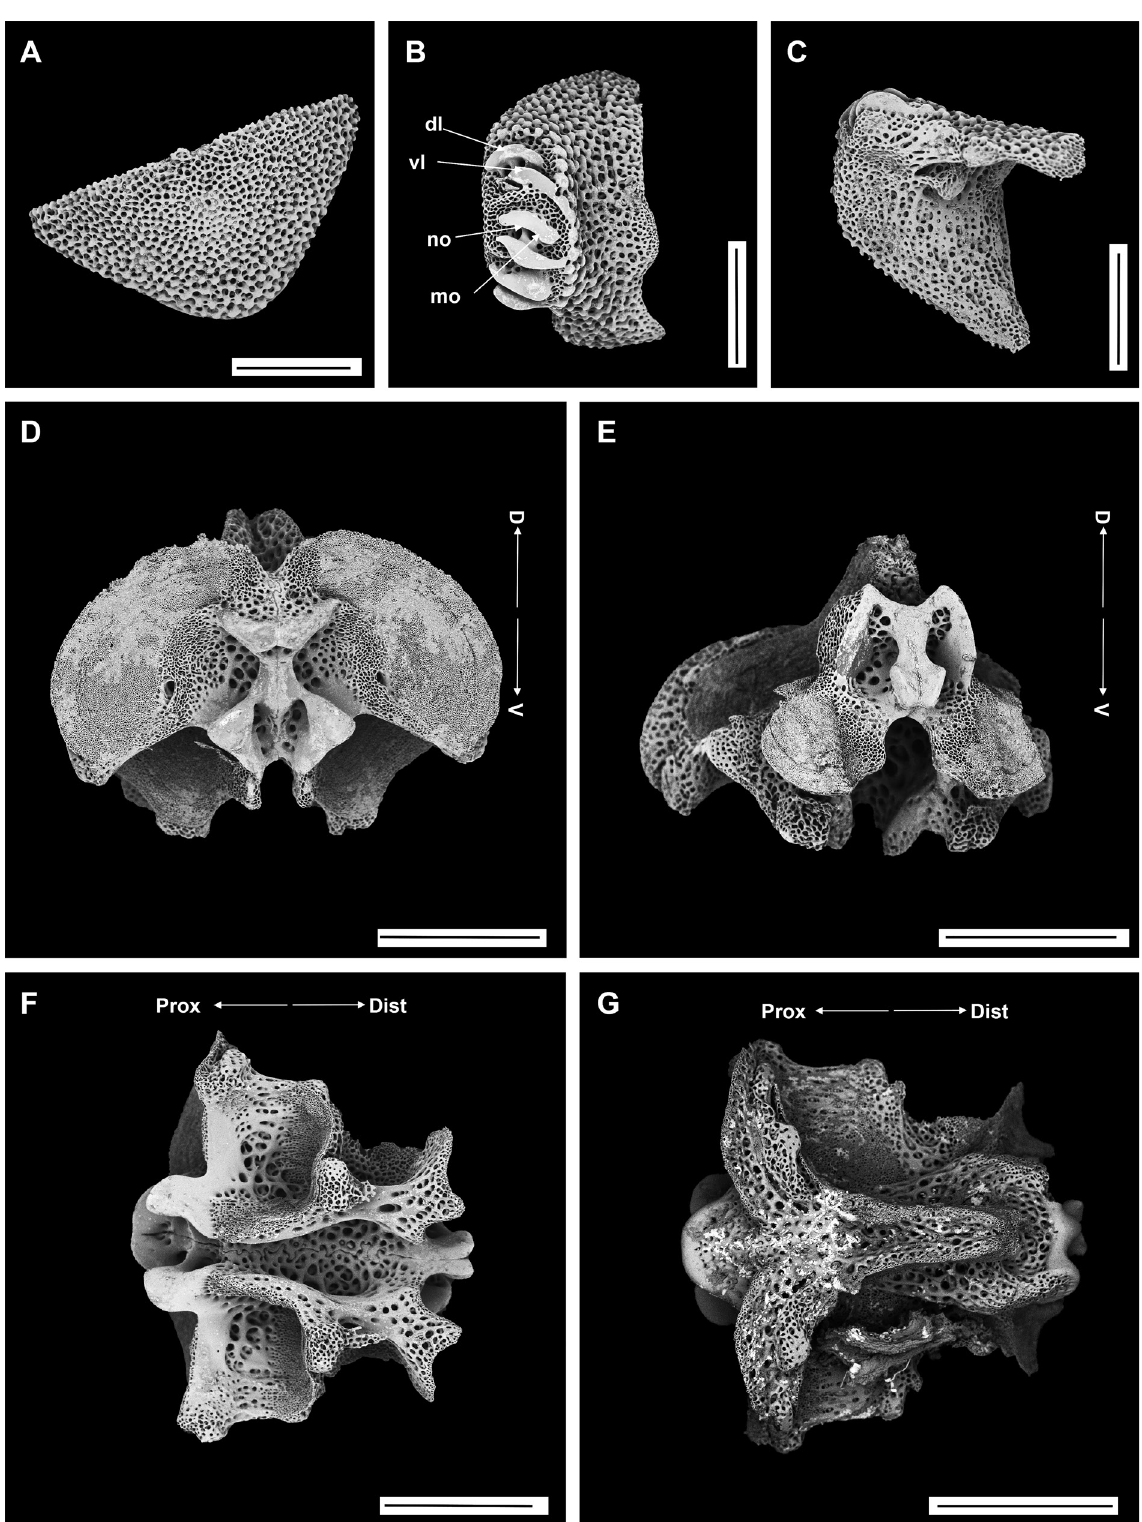
Fig. 39. Ophiactis profundi Lütken & Mortensen, 1889, SEM (IDSSE EEB-SW0017). A . Dorsal arm plate. B–C . Lateral arm plate (external, internal). D–G . Vertebrae. D . Proximal view. E . Distal view. F . Ventral view. G . Dorsal view. Abbreviations: D = dorsal; Dist = distal; dl = dorsal lobe; mo = muscle opening; no = nerve opening; Prox = proximal; V = ventral; vl = ventral lobe. Scale bars = 300